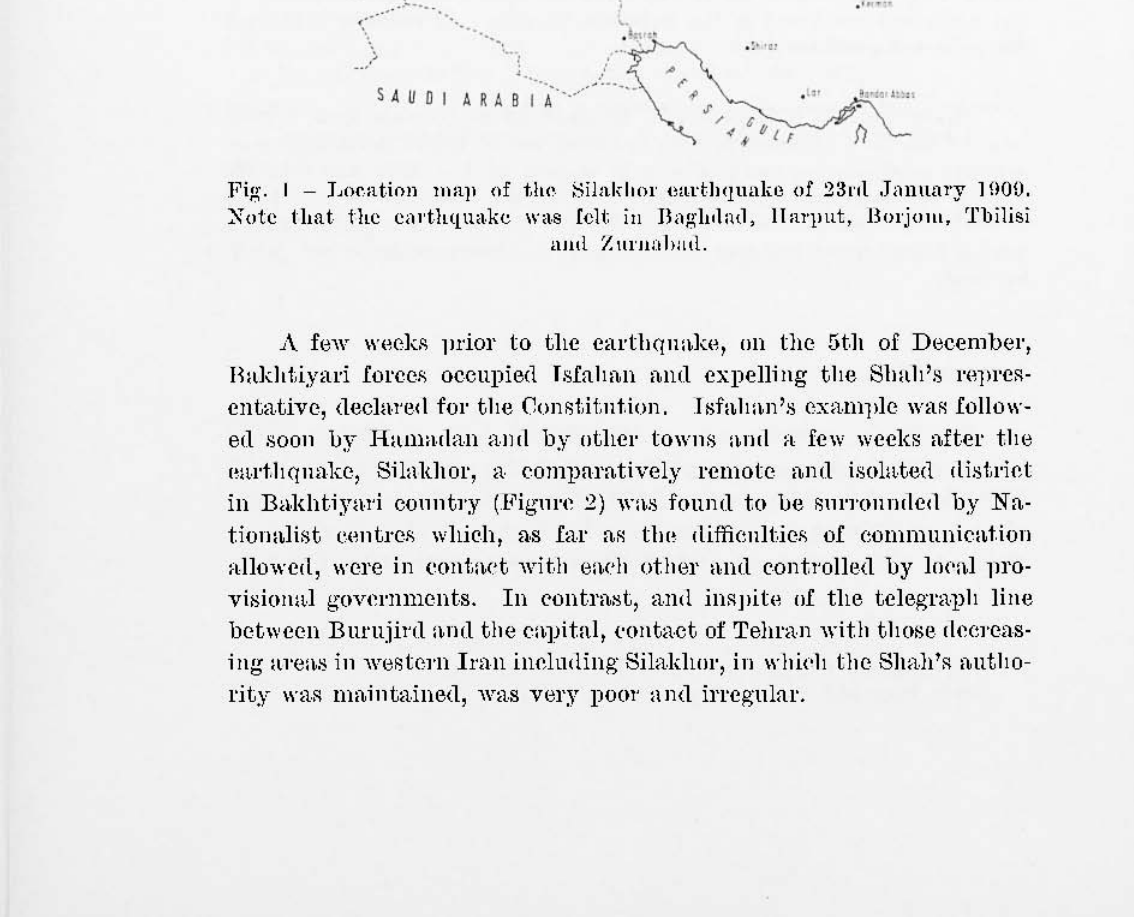
Fig. I - Locatioll 11m]) of tlw i::iilakllOl' eartlHjlwke or 231'11 .JamUll'y InUD. Xotc that thc ci1l'th(lUakc was [clt in Bagh,lml, lIal'put, BOl'jolll, Tbilisi ami Z Ul'Jltl